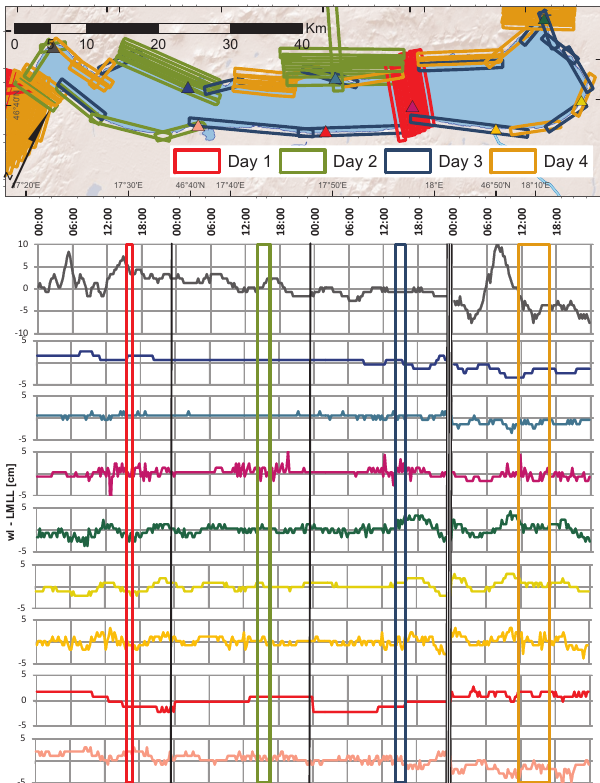
Figure 4. Water-level recordings with respect to LMLL of all 9 water-level gauges around Lake Balaton, during the 4 flight days. Triangles in the map depict the water gauges (colour coded to the water level graphs), rectangles crossing all graphs show actual flight times of lidar